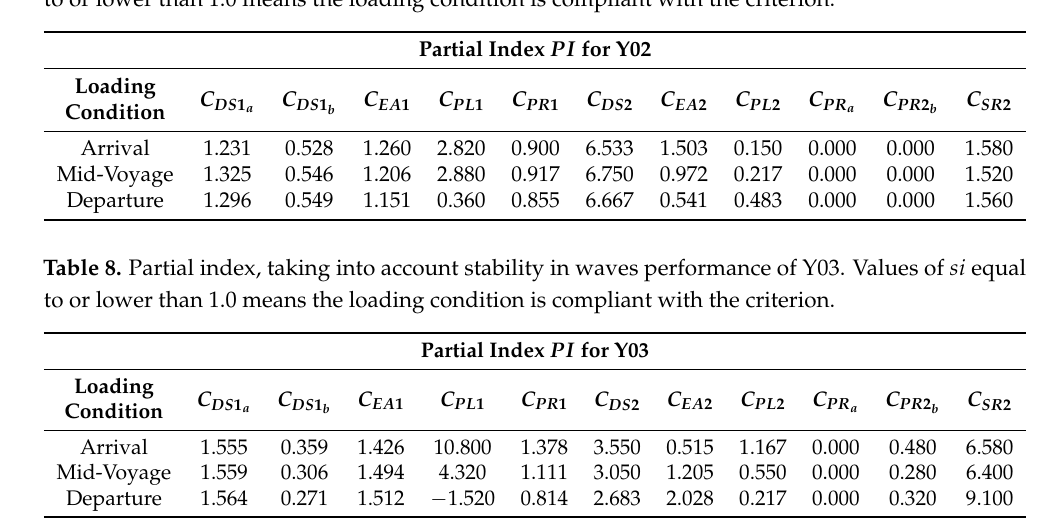
Table 7. Partial index, taking into account stability in waves performance of Y02. Values of si equal to or lower than 1.0 means the loading condition is compliant with the criterion.